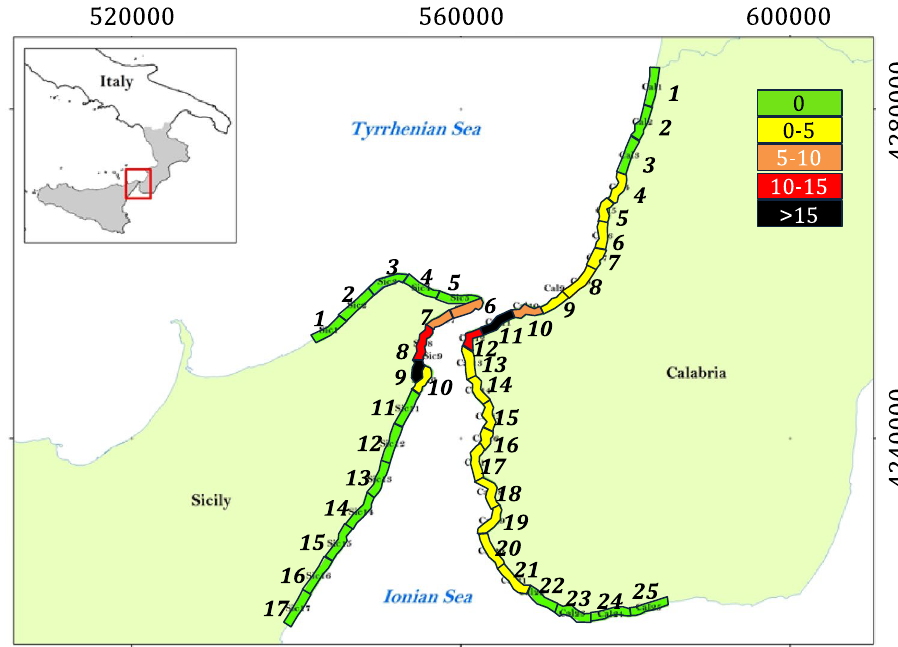
Figure 15. Modeled stranding shares (%) per each coastal element along the coasts of the Strait of Messina. Sicilian and Calabrian coasts were subdivided into 5 km-long stretches (clockwise from Sic1 to Sic17 for Sicily and counter clockwise from Cal1 to Cal25 for Calabria respectively) to count the stranding events. Along the Sicilian coast: Faro and Ganzirri beaches lay in Sic6; Pace beach lays in Sic7; S. Francesco beach lays in Sic8; Messina Harbour lays in Sic9; S. Raineri lays in Sic10. Along the Calabrian coast: Scilla beach lays in Cal10; Cannitello beach lays in Cal11, P.ta Pezzo beach lays in Cal12. Map was generated with QGis